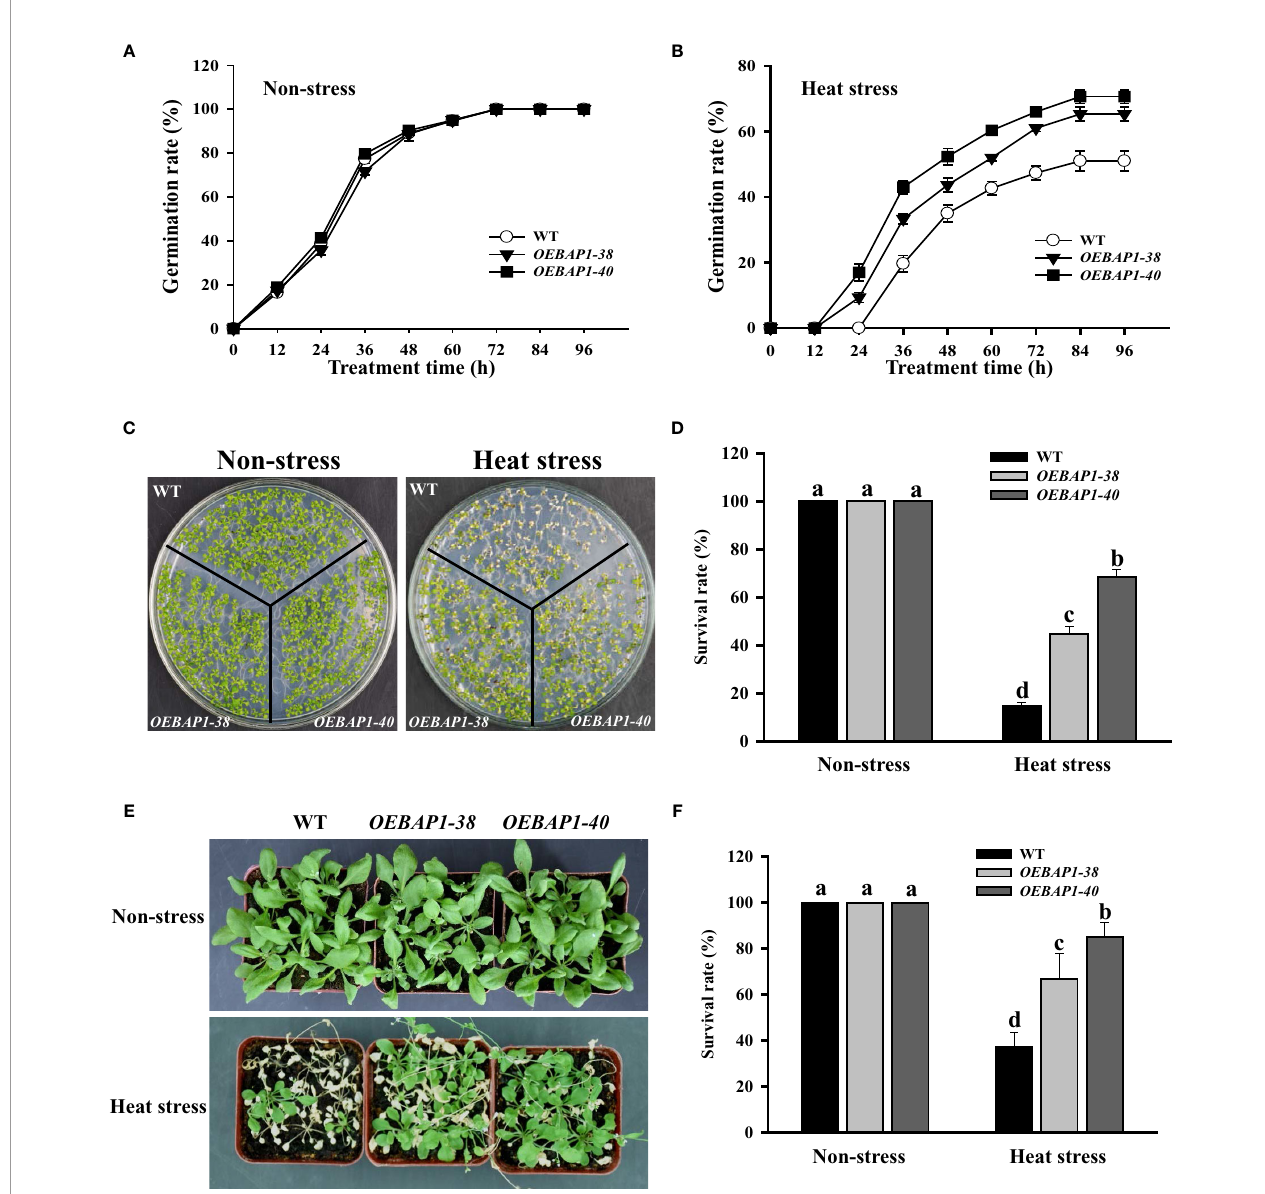
FIGURE 2 | Effects of high temperature on the growth of VvBAP1-overexpressing Arabidopsis plants. Time course of seed germination rates for the wild type and three independent transgenic Arabidopsis plants under a normal temperature (A) and after heat stress (B) . Each experiment was conducted at least thrice and more than 300 seeds were measured in each replicate. Values are the means ± SE of three independent experiments ( P < 0.05). The phenotype (C) and survival rates (D) of the wild type and three independent transgenic Arabidopsis seedlings under heat stress (45°C for 6 h). The phenotype (E) and survival rates (F) of the adult wild type and three independent transgenic Arabidopsis seedlings under heat stress (42°C for 8 h). Each experiment was conducted thrice. Values are the means ± SE of three independent experiments ( P < 0.05). Lower-case letters above bars denote signi fi cant differences attested by Tukey ’ s HSD